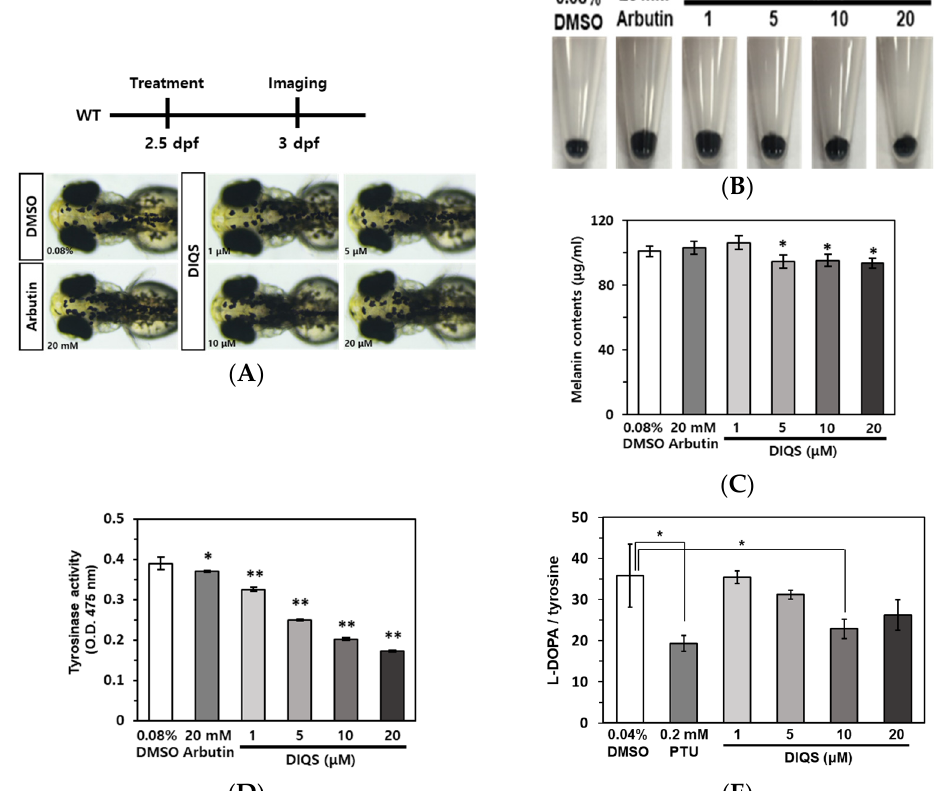
Figure 5 . DIQS treatment attenuated melanin content without melanophore damage. ( A ) Zebrafish were treated with DIQS at 2.5 days post-fertilization to evaluate its effects on melanophore morphology. Melanophores in DMSO-, arbutin-, and DIQS-treated zebrafish embryos were visualized using the Leica MZ10 F stereomicroscope. ( B ) Melanin pellets were prepared and photographed for comparisons between groups. ( C ) Melanin content was analyzed in zebrafish embryos. ( D ) Tyrosinase activity was measured as described in the Materials and Methods. ( E ) Tyrosine and L-DOPA in zebrafish embryos were quantitatively analyzed by liquid chromatography–tandem mass spectrometry (LC–MS/MS). Data are L-DOPA/tyrosine ratios. * p < 0.05; ** p < 0.01 (vs. the DMSO-treated group).